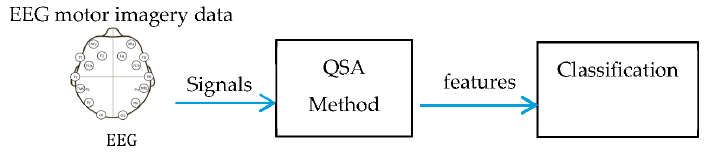
Figure 2. Block diagram of the overall EEG signal classification strategy.